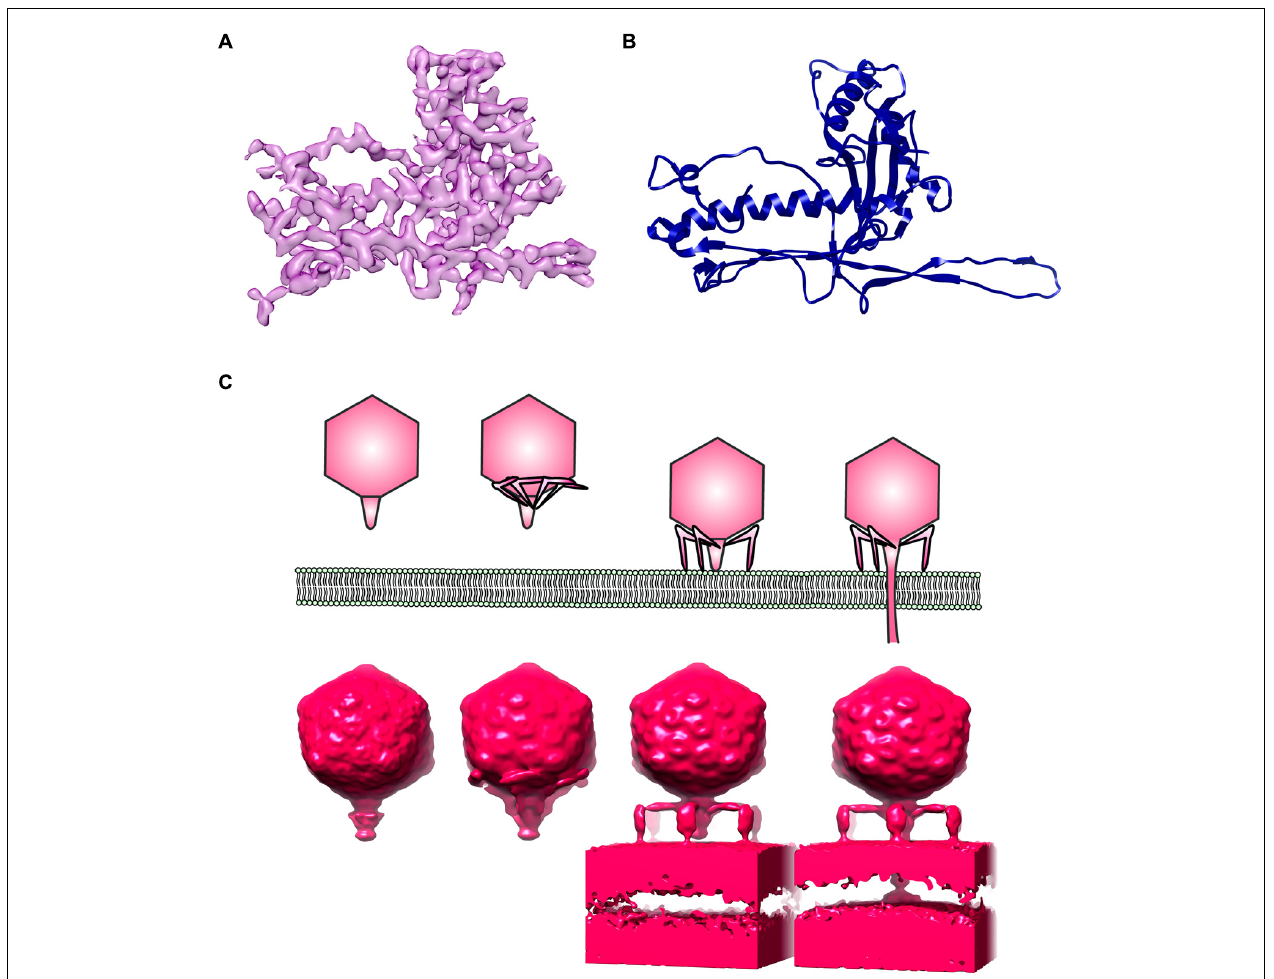
different stages ofT7 phage infection derived from electron cryotomography based on Hu etal. (2013); bottom shows surface rendition of electron density map generated from electron cryotomography and subtomogram averaging (Images rendered from deposited EMDB structures, EMD-5534, EMD-5535, EMD-5536, EMD-5537; Hu etal.,